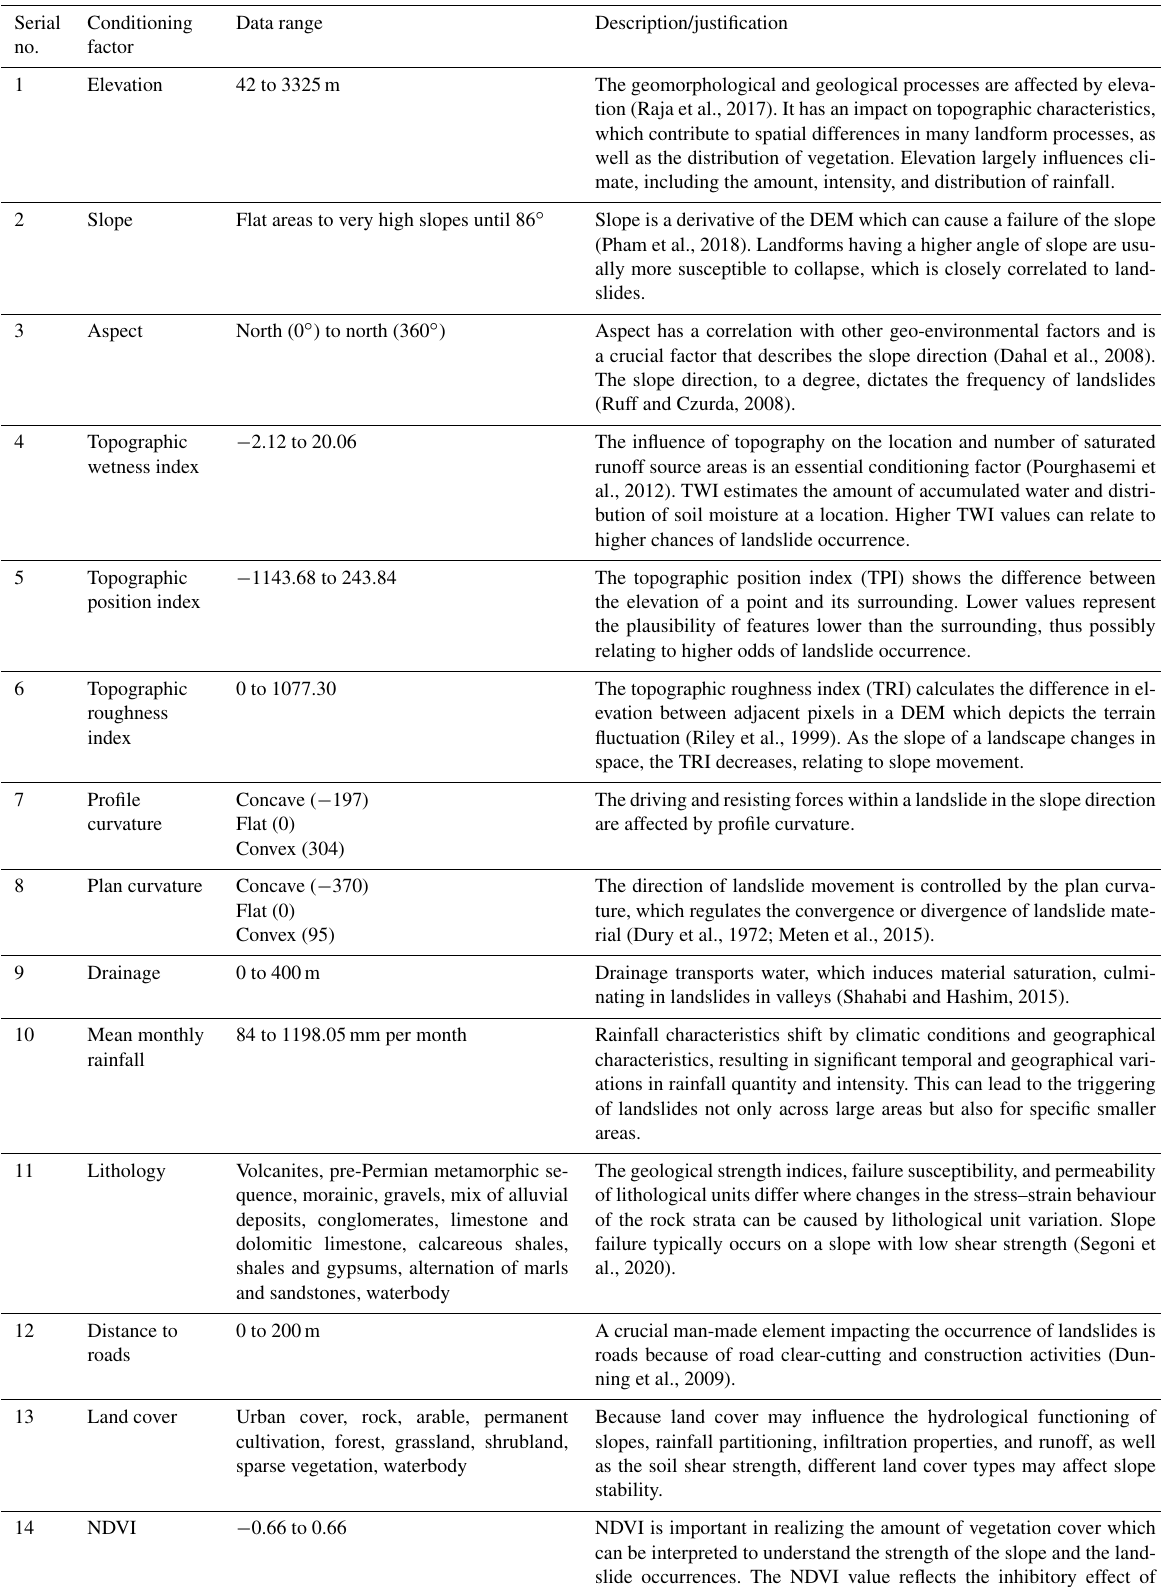
Table 1. Description of the conditioning factors for landslide